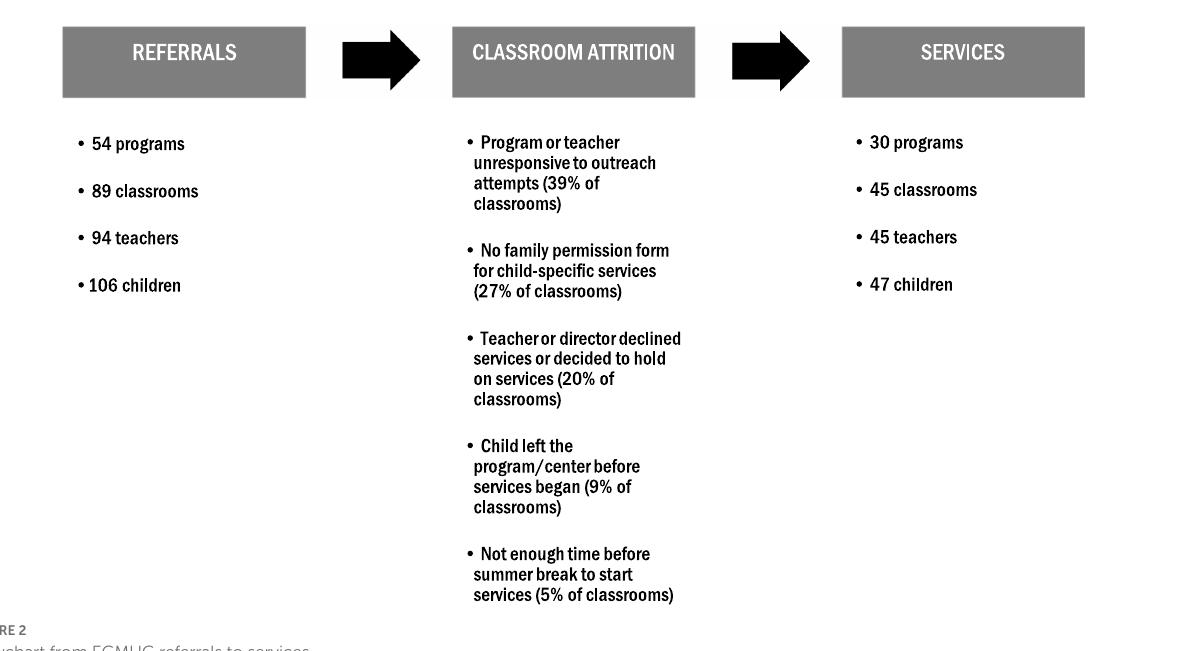
FIGURE 2 Flowchart from ECMHC referrals to